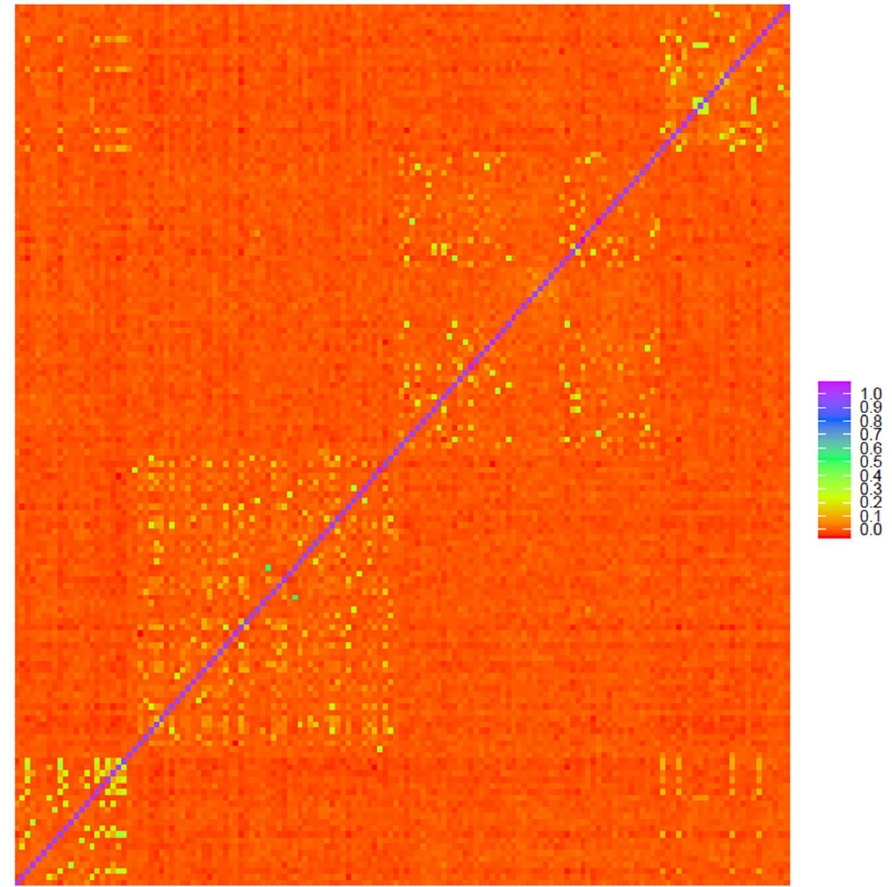
Figure 3. Heat map of genomic relationships among animals based on microarray genotyping Gacocen (bottom left), Pacomarca and Quimsachata (center area) and Racco (top right).